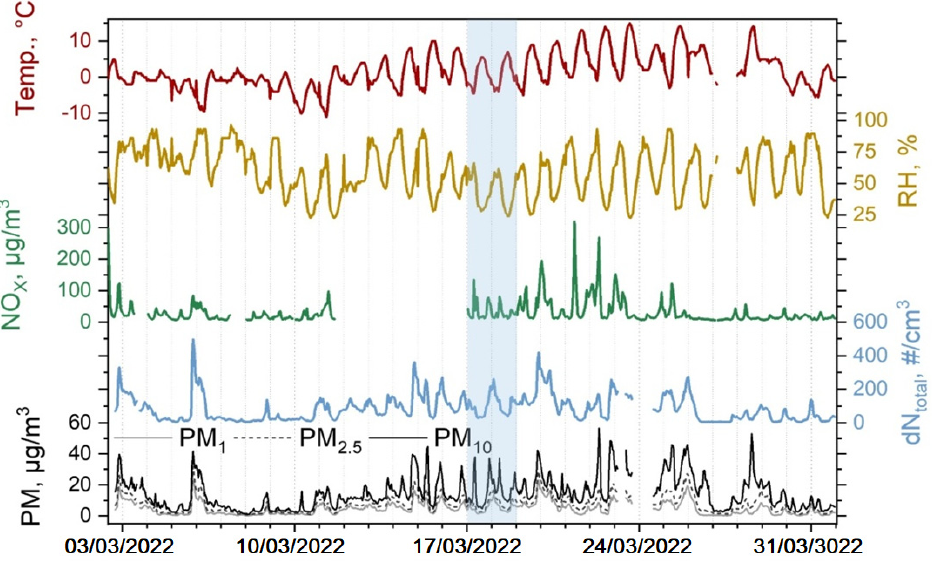
Figure 2. Fixed measurements of meteorological parameters: temperature (red), relative humidity (yellow), NO x concentration (green), total particle number concentration N total (blue), and PM 1 , PM 2.5 , PM 10 mass concentrations (black, dotted line, grey, respectively) during March 2022 (experiment days are marked in blue